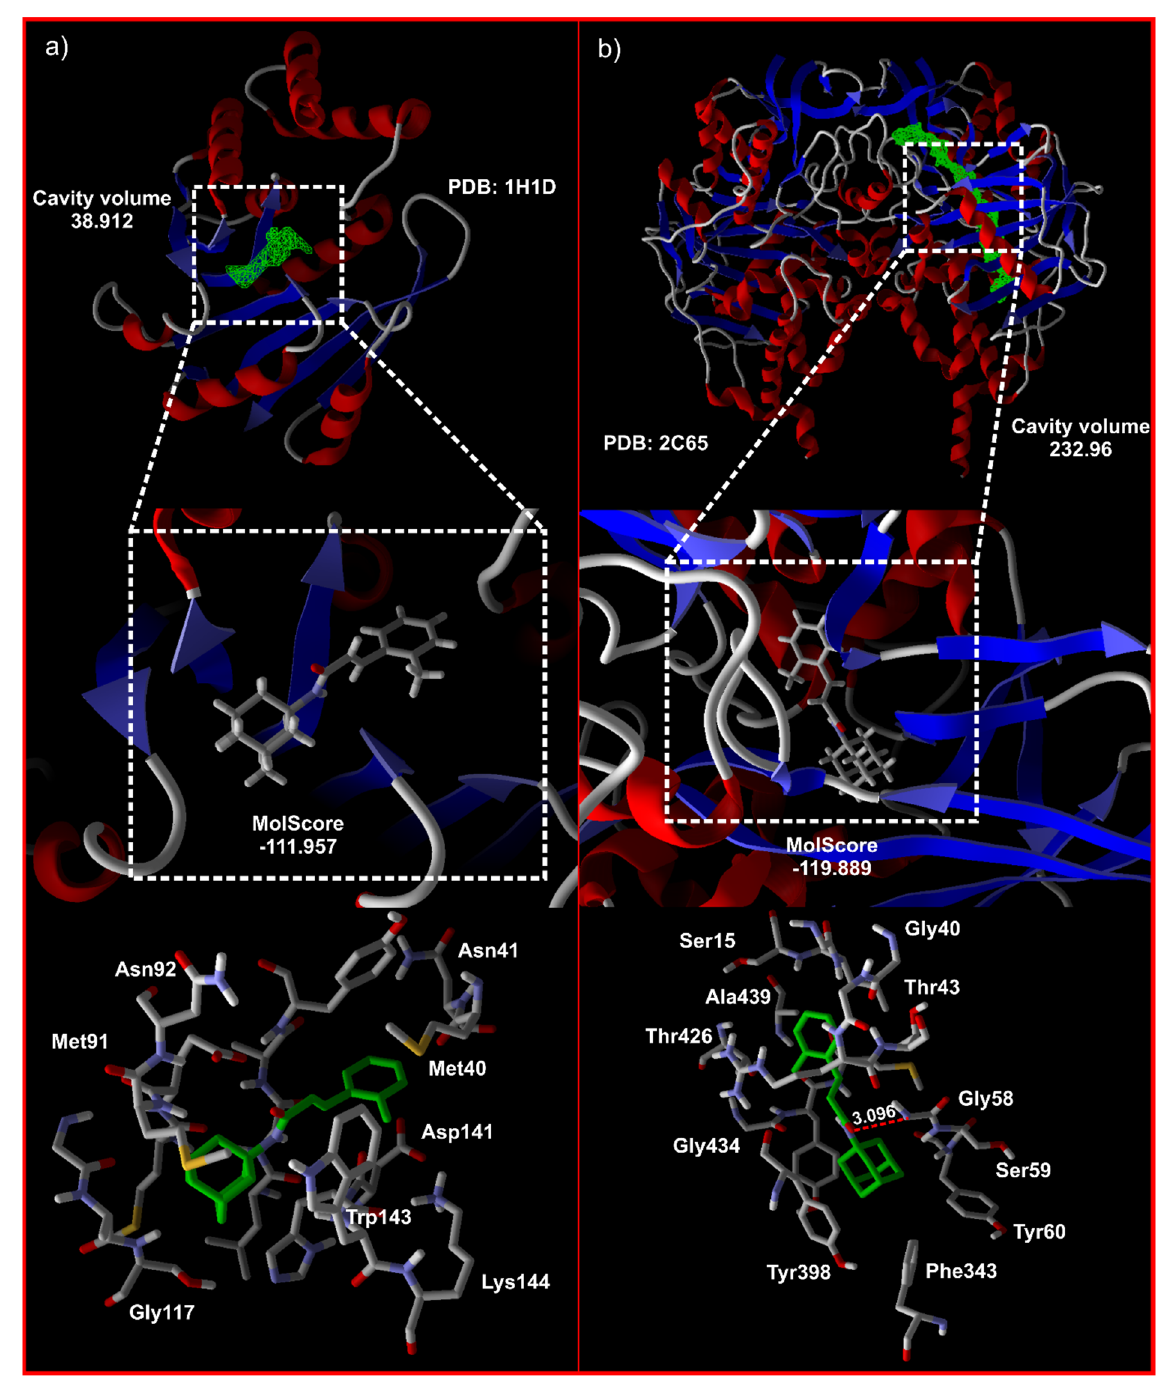
Figure 6. Visualization of the docking studies and molecular interaction of ( E )- N -(2-methylcinnamoyl)-amantadine with ( a ) COMT and ( b ) MAO-B. The hydrogen bonding interaction N -H…O=C is shown in as red dashed line with the A…D distance of 3.096 Å.